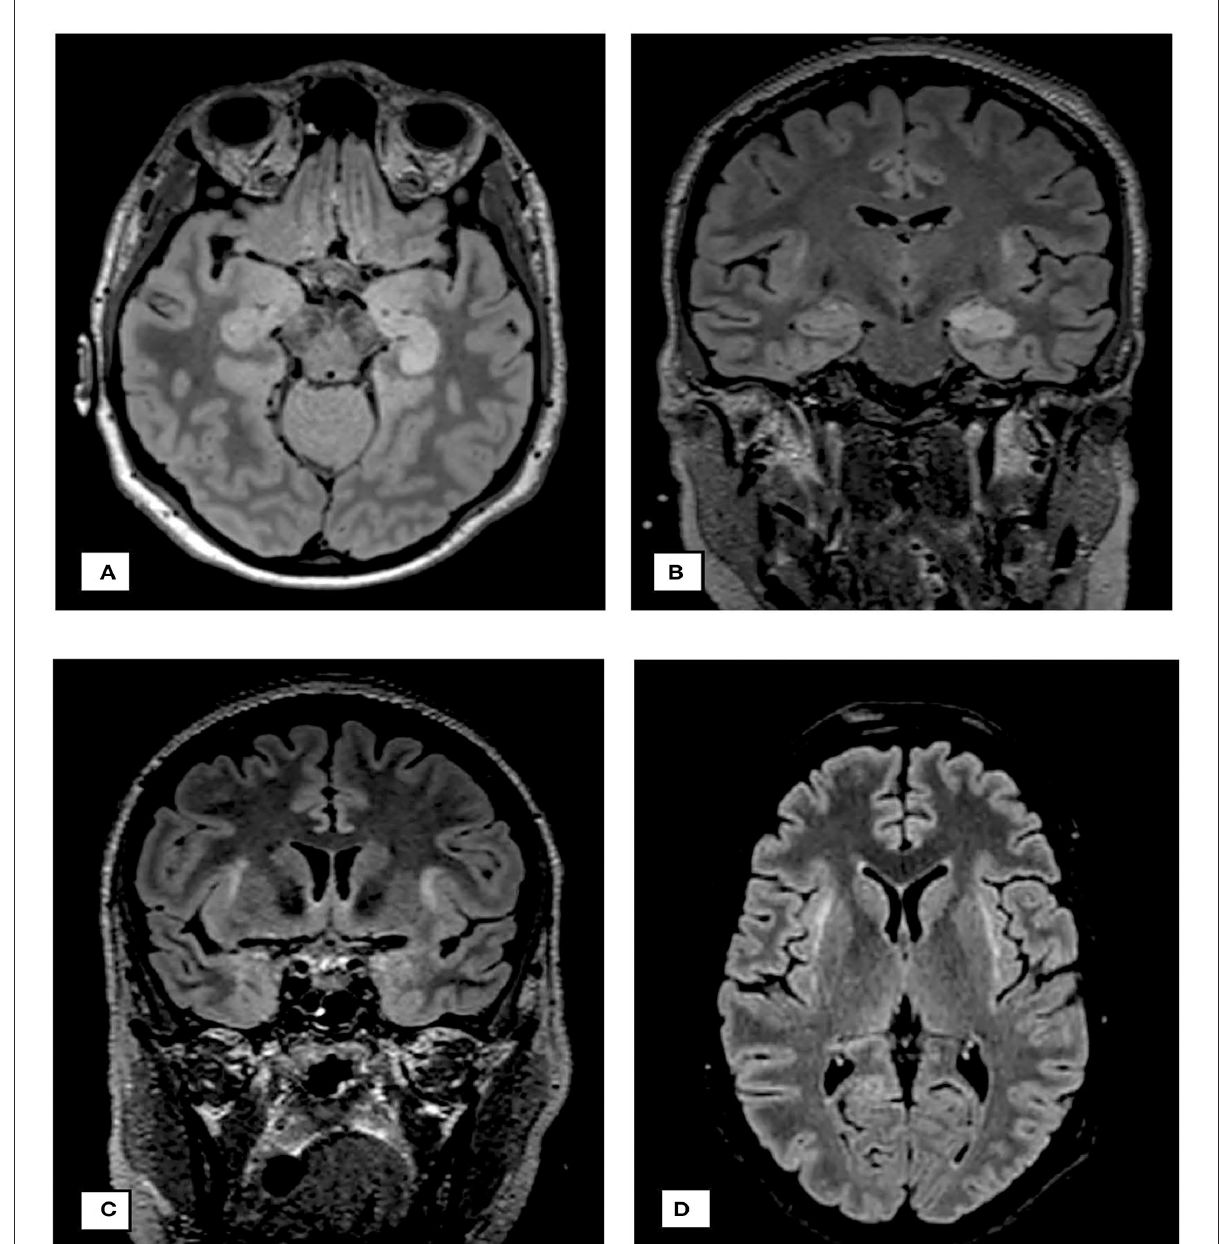
FIGURE3 Neuroimaging findings. (A) cMRI on day 13: axial FLAIR sequence demonstrating edematous changes in hippocampus and parahippocampal gyrus predominantly on the left side. (B) cMRI on day 23: coronary FLAIR sequence demonstrating progression of edema on both sides, the hippocampus and parahippocampal gyrus, additional subcortical FLAIR hyperintensities subinsular on both sides. (C,D) demonstrate the claustra